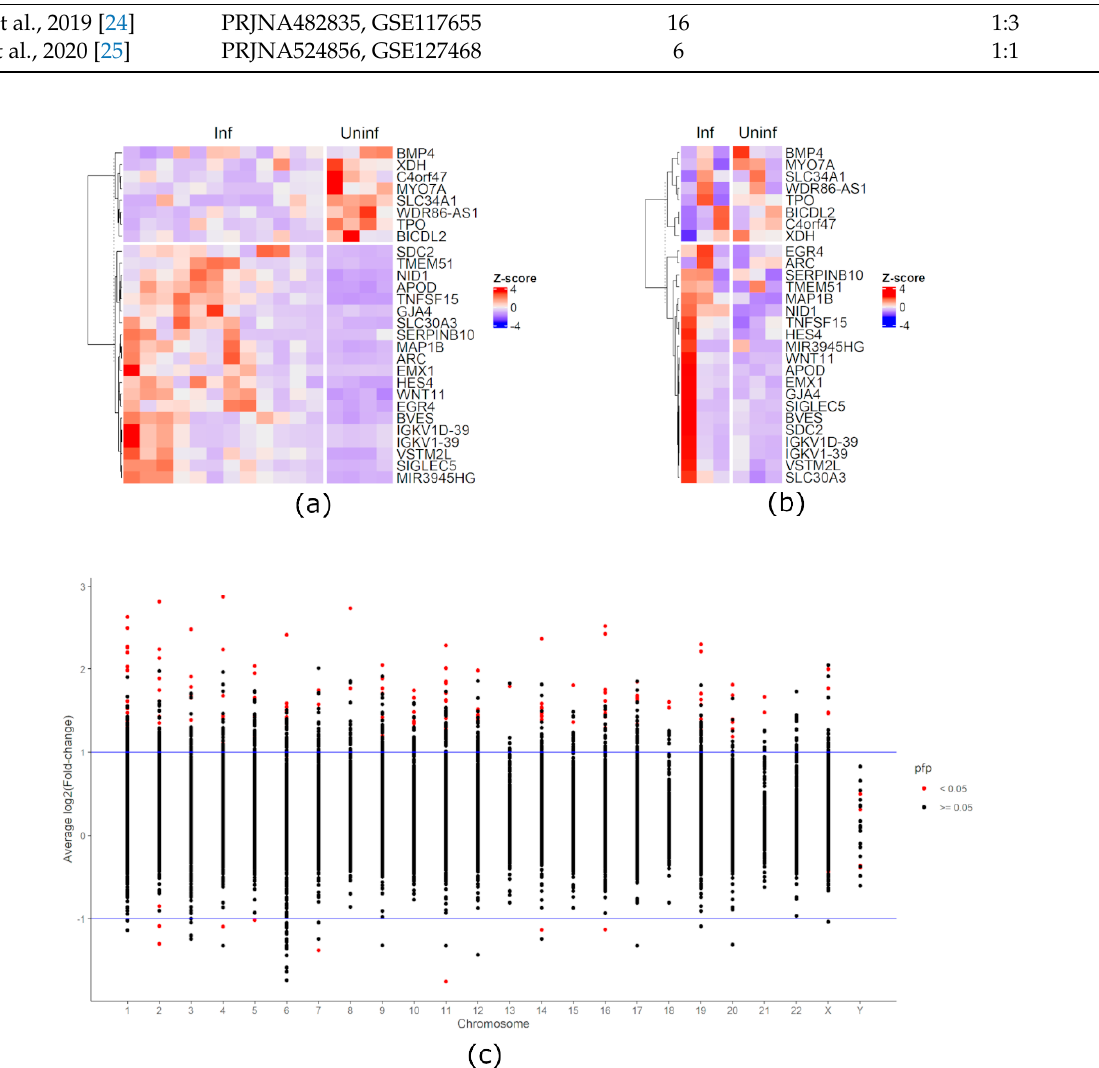
Figure 1. Trimmed mean of M-values (TMM)-normalized [26] and standardized heatmaps gene expression of: ( a ) Langer et al. (2019) [24] and (b) Shytaj et al. (2020) [25]. Both ( a ) and ( b ) display the 8 down-regulated genes and the first 20 up-regulated genes ranked by percentage of false prediction (pfp)-adjusted p -value. ( c ) Stripchart of average log2(Fold-change) of genes in infected cells when compared to uninfected/mock-infected cells identified by rank product method. Red dots in ( c ) represent differentially expressed genes with percentage of false prediction (pfp)-adjusted p -value < 0.05. The horizontal blue lines demarcate the |log2(Fold-change)| thresholds.